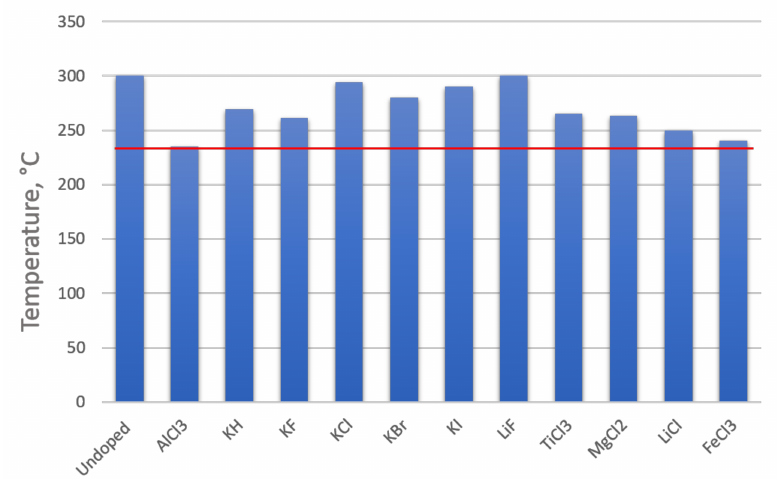
Figure 3. Maximum desorption peak temperatures as a function of different additives on the LiNH 2 -LiH system. The red line is set on the AlCl 3 dopant to highlight its performance. Gennari et al. [38] also tested the contribution of MgH 2 , CaH 2 and TiH 2 in enhancing the